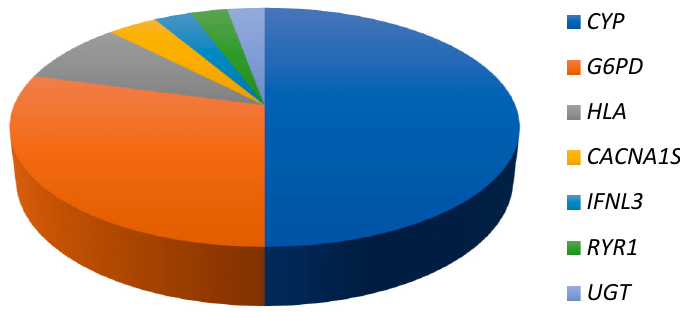
Figure 1. Importance of CYP pharmacogenomics. The pie chart depicts the percentage that each set of pharmacogenes contributes in priority drug–gene pair interactions with two or more drugs.